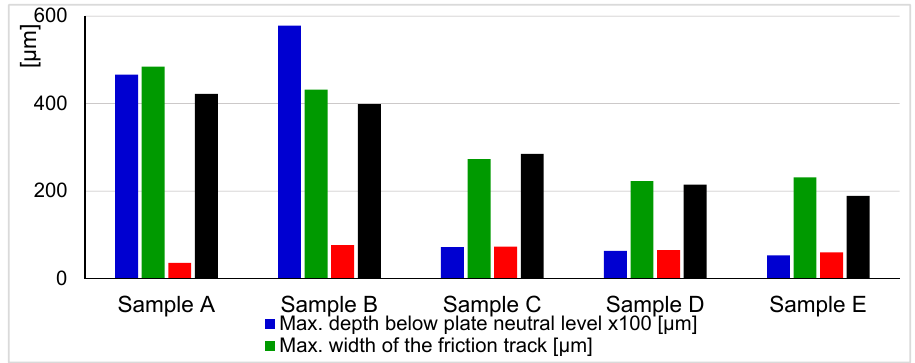
Figure 3. Key parameters describing friction wear of the samples.